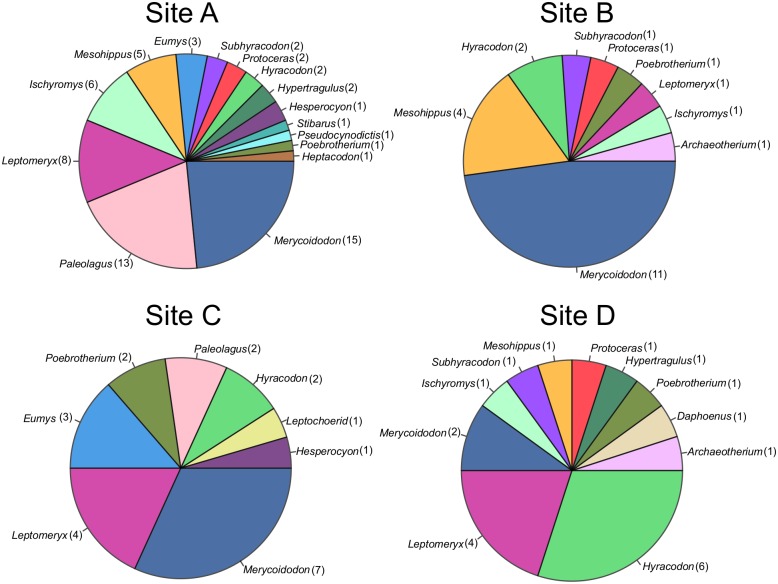
Distribution of Taxa by Facies.Distribution of taxa at sandstone versus siltstone hosted sites is indistinguishable in both environments. All specimens identifiable to genus are included. 87 specimens from the sandstone sites were included, 42 from the siltstone hosted sites.